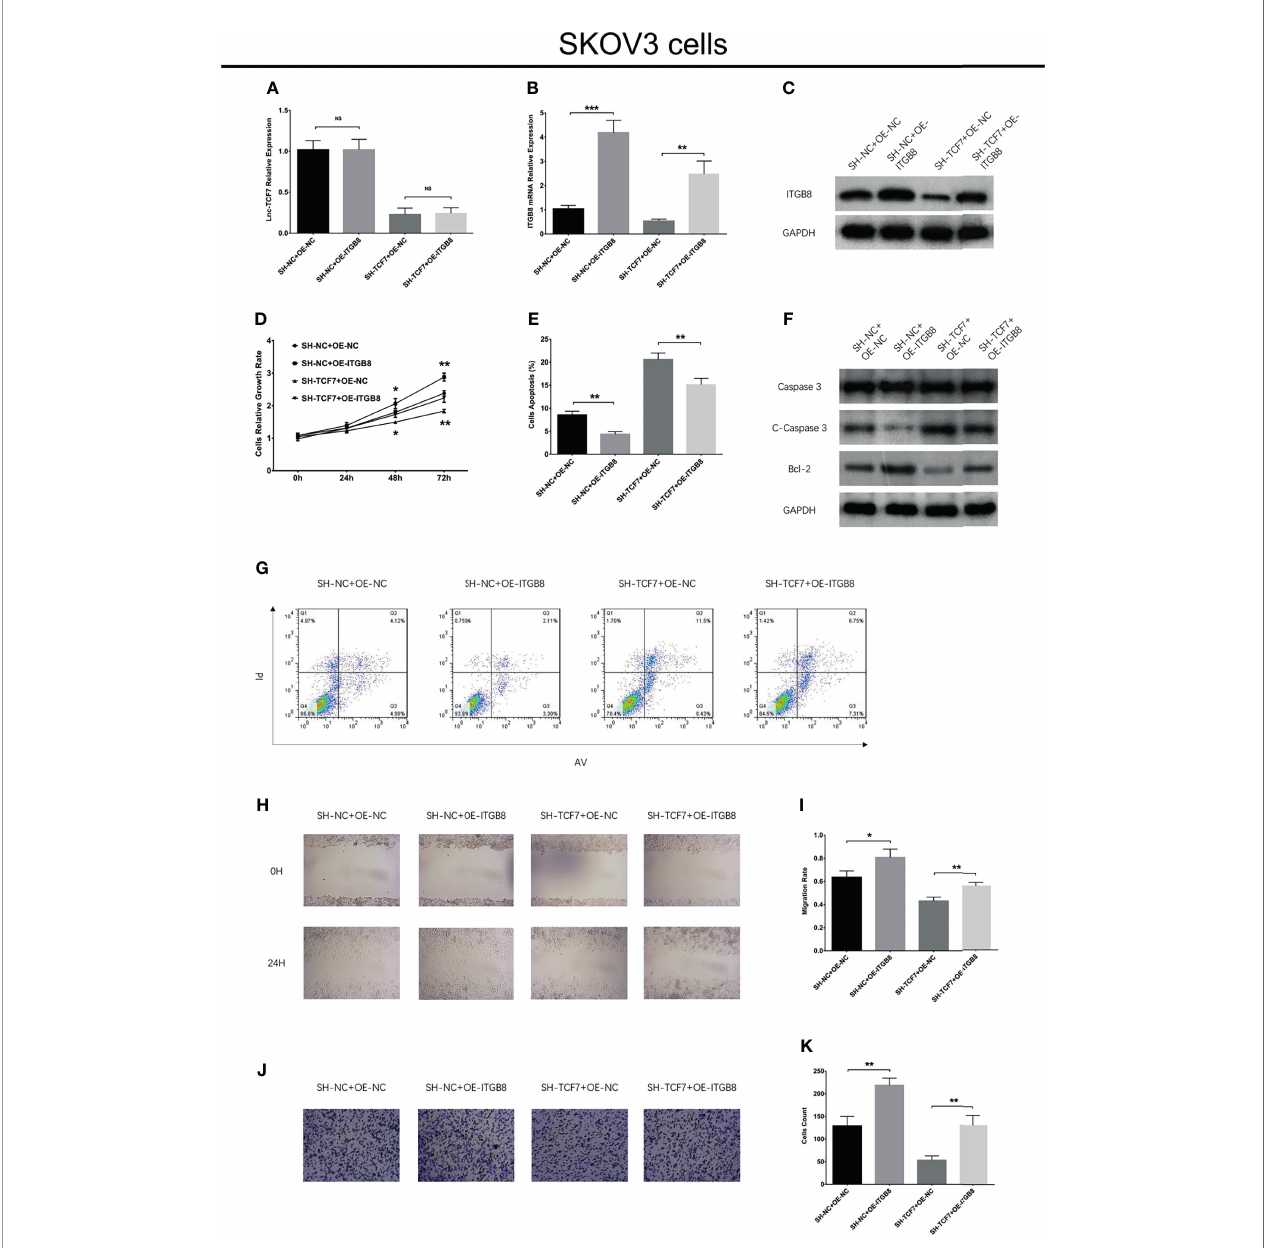
FIGURE 5 | Effect of ITGB8 overexpression on cell proliferation, apoptosis, migration and invasion in SKOV3 cells. Lnc-TCF7 expression (A) , ITGB8 expression (B, C) , cell proliferation (D) , cell apoptosis rate and apoptotic markers (E – G) , cell migration (H, I) , cell invasion (J, K) after corresponding transfections. Experiments were performed in triplicates. * represented P < 0.05, ** represented P < 0.01, *** represented P < 0.001, ns represented no signi fi